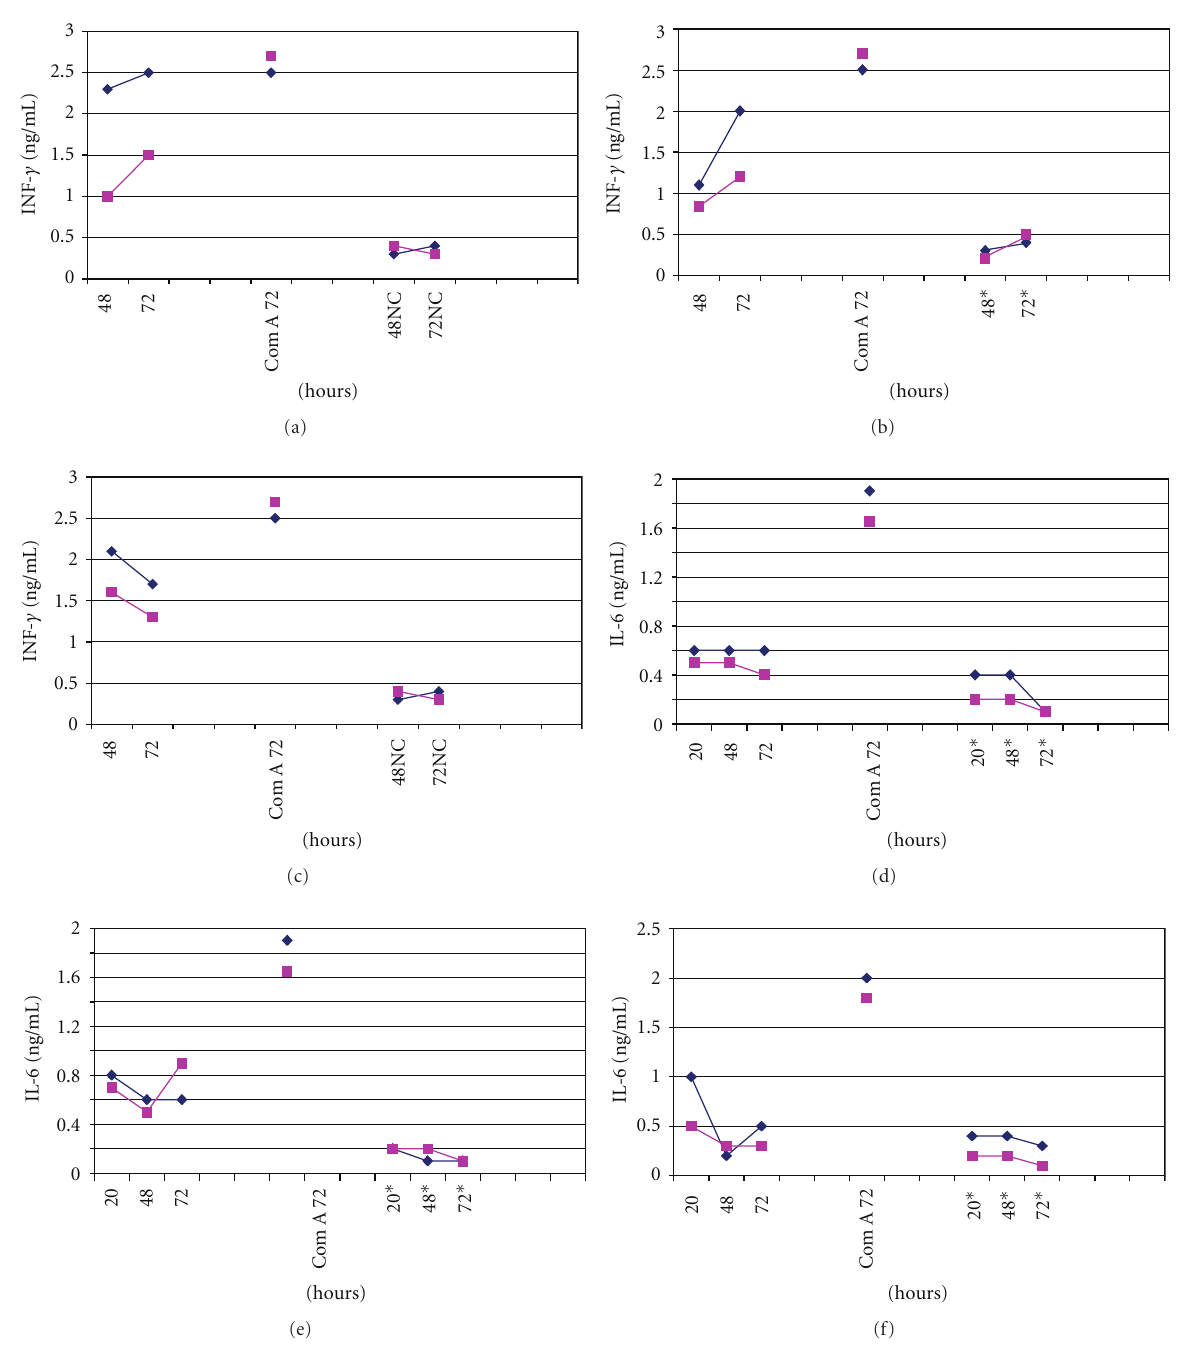
Figure 7: Production of IFN γ and IL-6 in adult BALB/c mice after four i.n. doses of 20 μ g of OMP of N. meningitidis and 2 μ g of (a) Stx1 toxoid, (b) Stx2 toxoid, or (c) CT. The spleen cultures were stimulated in vitro with 1 or 2 μ g of the homologous antigen used for immunization, and the supernatants were harvested after 48h, and 72 h of culture for IFN- γ or 20 h, 48 h and 72 h for IL-6. IFN- γ concentrations are expressed in ng/mL. IL-6 concentrations are expressed in pg/mL . Normal cells ∗ and concanavalin A were used as